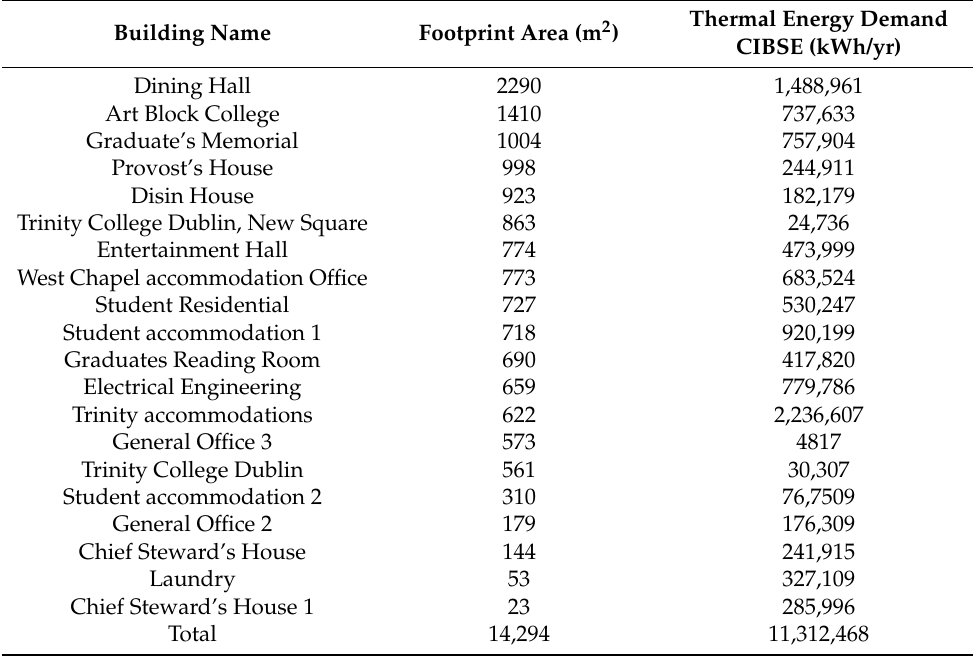
Table 1. Information of the buildings heated by the DH system.